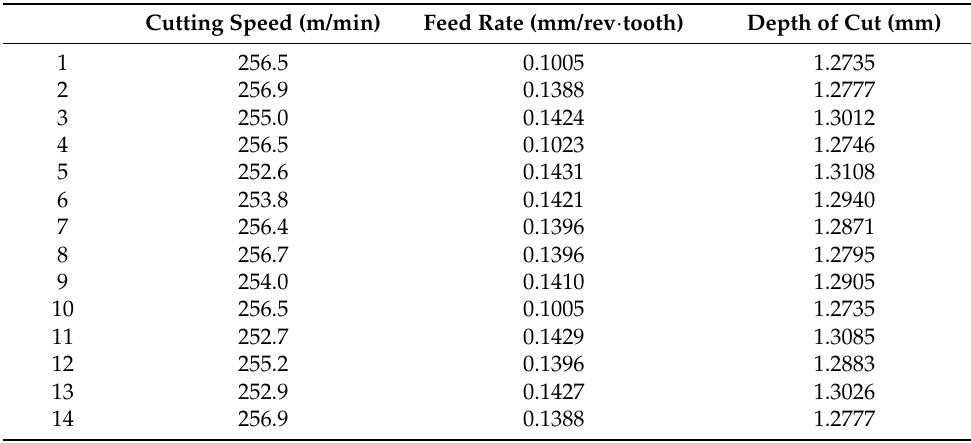
Table 3. The obtained results using multi-objective